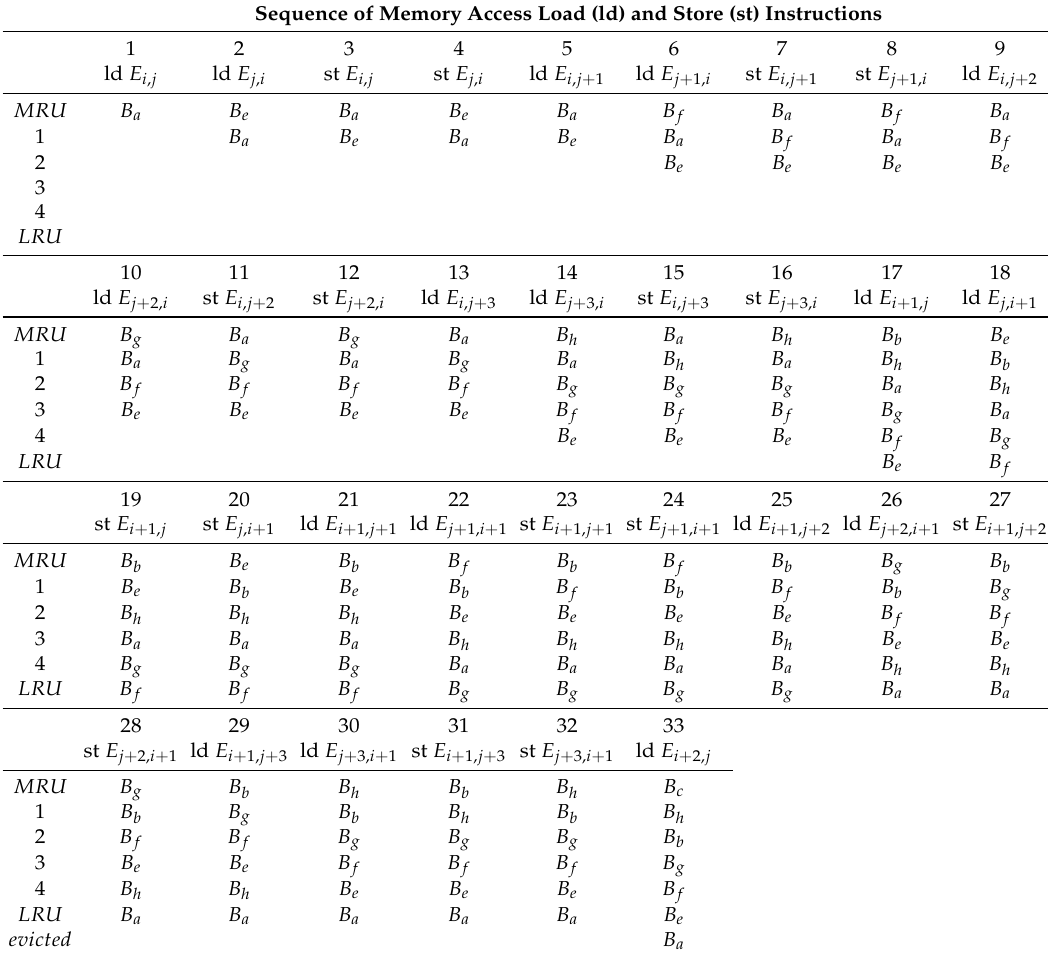
Table 1. Evolution of the LRU stack content during a tile transposition in a cache with L = T = 4 and S = 1. Each LRU stack snapshot is taken after the execution of ld and st instructions that access the E row , column elements, and it shows the ordered sequence of all the previously accessed B i cache lines. Sequence of Memory Access Load (ld) and Store (st)